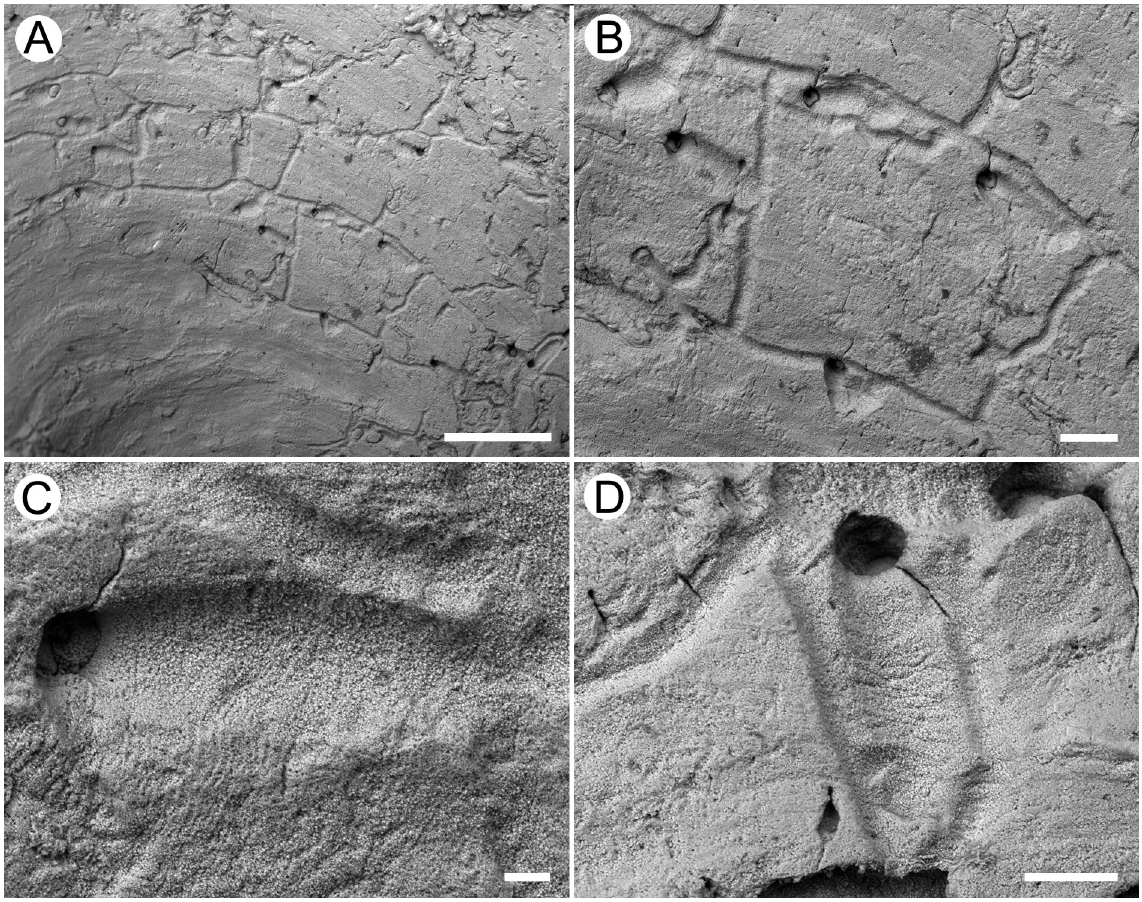
Fig. 1. Buskia waiinuensis sp. nov., holotype (GNS BZ 335), Nukumaruan, Pleistocene, Nukumaru Limestone, Waiinu Beach, New Zealand. A . General view of the bioimmured colony, showing the regular development of the stolonal pattern. B . Close-up of a sector of the colony. C . Close-up of a zooid with oval orifice. Note the cystid appendage lateral to the orifice and the concentric lines on the zooidal and stolonal surface. D . Close-up of a zooid with a circular orifice and two cystid appendages lateral to the orifice. Scale bars: A = 1 mm; B = 200 µm; C = 50 µm; D = 100